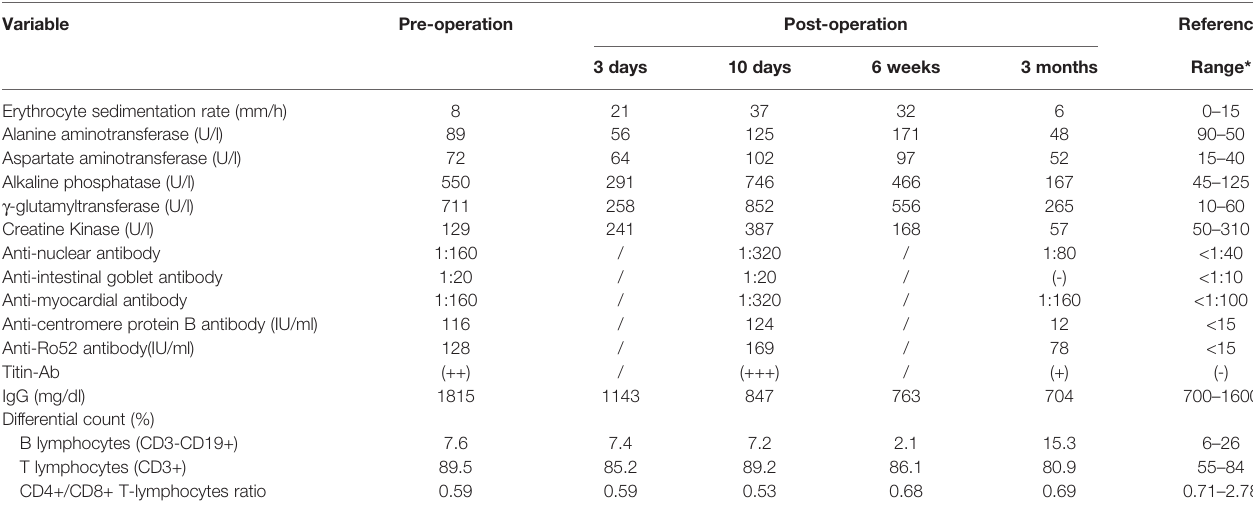
TABLE 1 | Laboratory data.